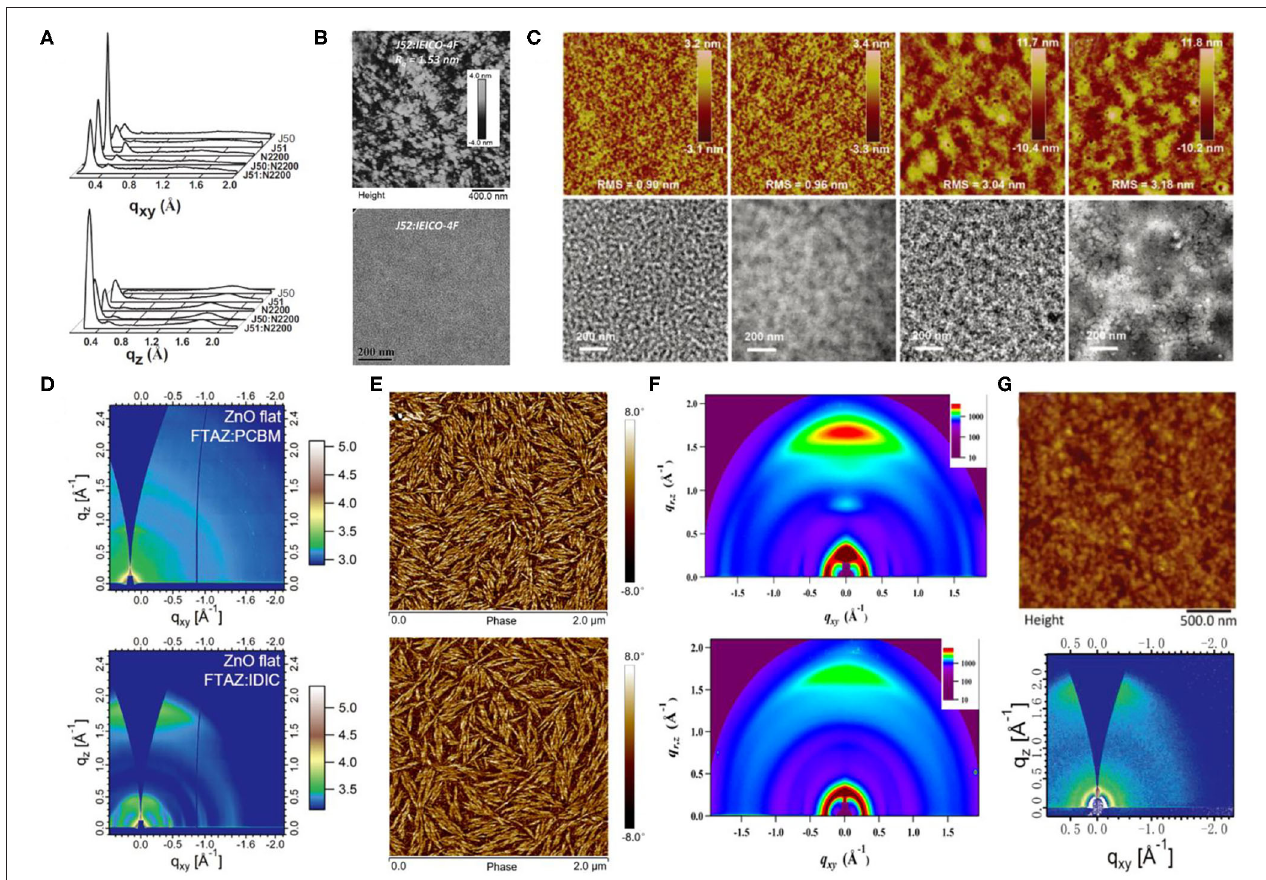
FIGURE 9 | (A) Line cuts of GIWAXS images in in-plane (top) and out-of-plane (bottom) direction for the polymers J50, J51, N2200, and the polymer blends of J51:N2200 (2:1, wt/wt) and J50:N2200 (2:1, wt/wt) films. Copyright 2015, Wiley-VCH. (B) AFM height image (top) and TEM pattern (bottom) of the binary films at a donor ratio of 0.3:0.7. Copyright 2017, Wiley-VCH. (C) AFM height images (5 × 5 µ m, top) and TEM images (bottom) for PTzBI:ITIC, PTzBI:ITIC processed with 0.5% dibenzyl ether (DBE), PTzBI-DT:ITIC and PTzBI-DT:ITIC processed with DBE/DIO (from left to right). Copyright 2017, Wiley-VCH. (D) The 2D GIWAXS patterns for FTAZ:IDIC and FTAZ:PCBM blended films with 0.25% DIO on flat ZnO substrates. Copyright 2018, Wiley-VCH. (E) AFM phase images for D18:Y6 blend films without (top) and with (bottom) SVA. Copyright 2020, Science China Press. (F) 2D GIWAXS patterns of (top) neat PDBT-T1 film and (bottom) optimal PDBT-T1:SdiPBI-Se blend film (0.25% DIO). Copyright 2015, American Chemical Society. (G) Tapping mode AFM topography (top) and 2D GIWAXS image (bottom) of PzNDT-T-BDD/IDIC blend film. The size of the AFM image is 2.5 × 2.5 µ m. Copyright 2018,